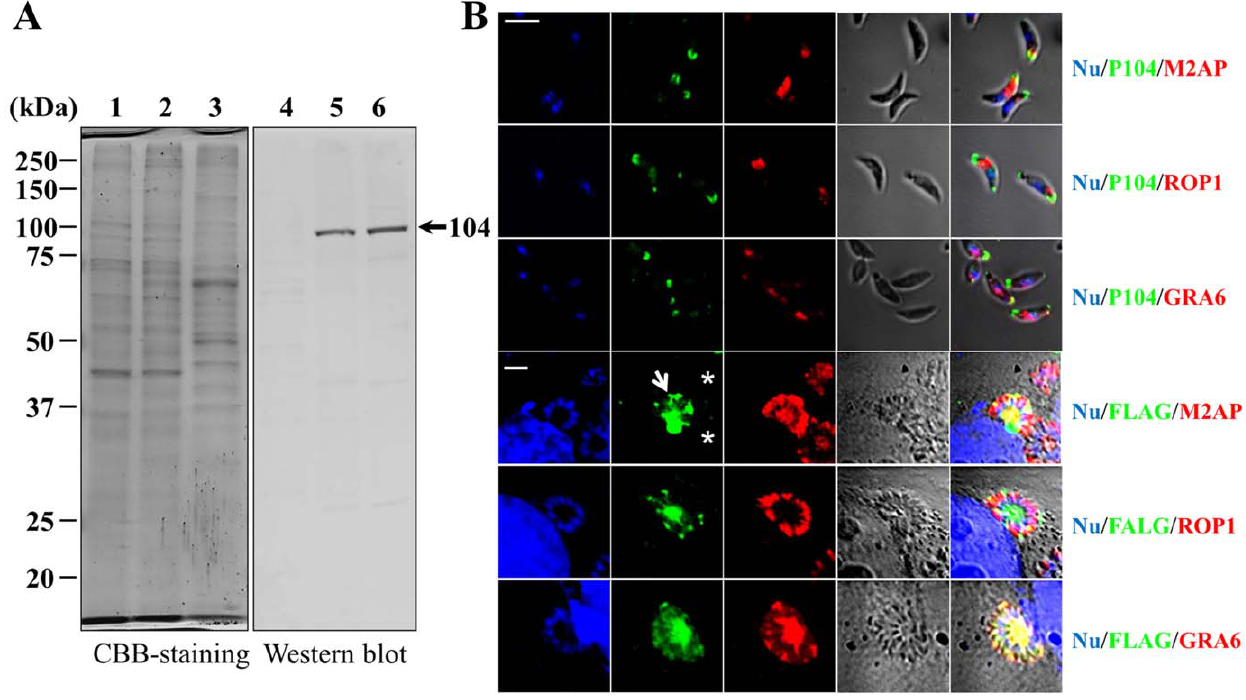
Figure 3. Localization of P104 in intracellular and extracellular T.gondii . A. Western blot analysis of P104 in the T. gondii lysate. Lane 1 and 4, Vero cell lysate; lane 2 and 5, lysate of T. gondii -infected Vero cells; lane 3 and 6, lysate of purified T. gondii . Lane 1–3, CBB-staining of Vero cell and T. gondii lysate; lane 4–6, Western blotting of the lysates. Mouse anti-rP104-1-S/GST was used as the primary antibody. The molecular masses in kDa are shown on the left. B. Co-localization assays of P104 with other proteins in extracellular (upper 3 panels) and intracellular (lower 3 panels) T. gondii . Green, anti-rP104-1-S/GST antibodies; red, anti-M2AP, anti-ROP1 and anti-GRA6 antibodies; blue, nuclei (with TO-PRO-3 staining). In intracellular T. gondii (lower 3 panels), mouse anti-FLAG antibody, instead of anti-rP104-1-S/GST, was used to stain the recombinant protein of P104 with a C- terminal FLAG tag (green stained, arrows). Wild-type parasites that failed to be stained with anti-FLAG antibody were indicated with stars.